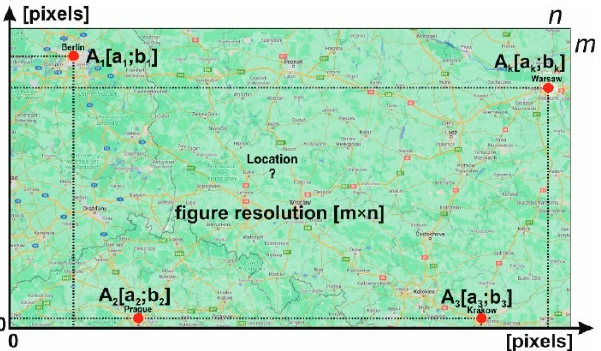
Figure 7. Image resolution is the basis for the data input into the location calculation.